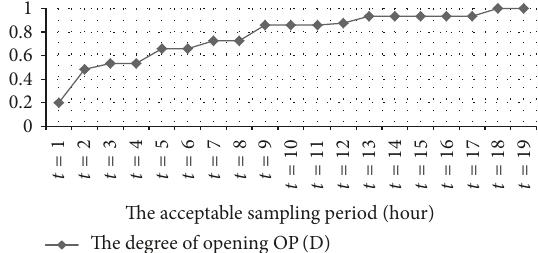
Figure 3: The OP (𝐷) of the proposed algorithm under different acceptable sampling periods.